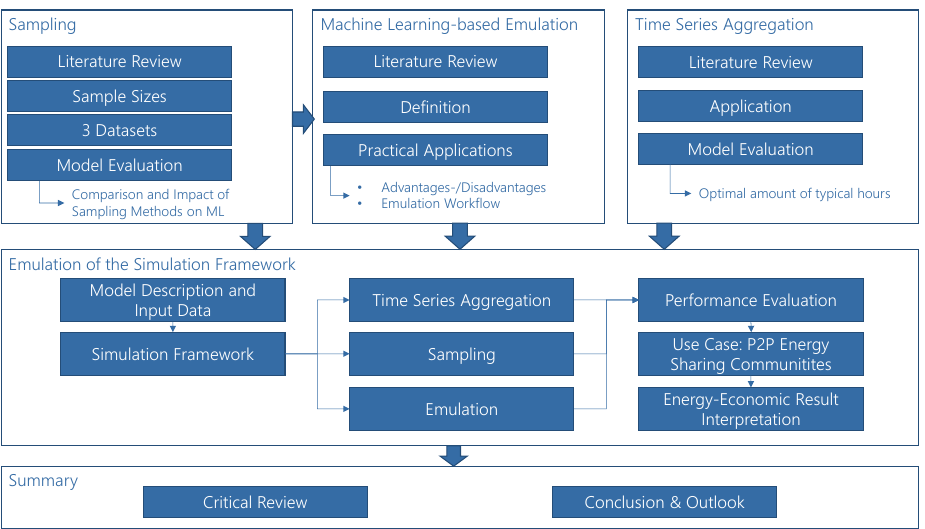
Figure 3. Methodology applied in this paper.